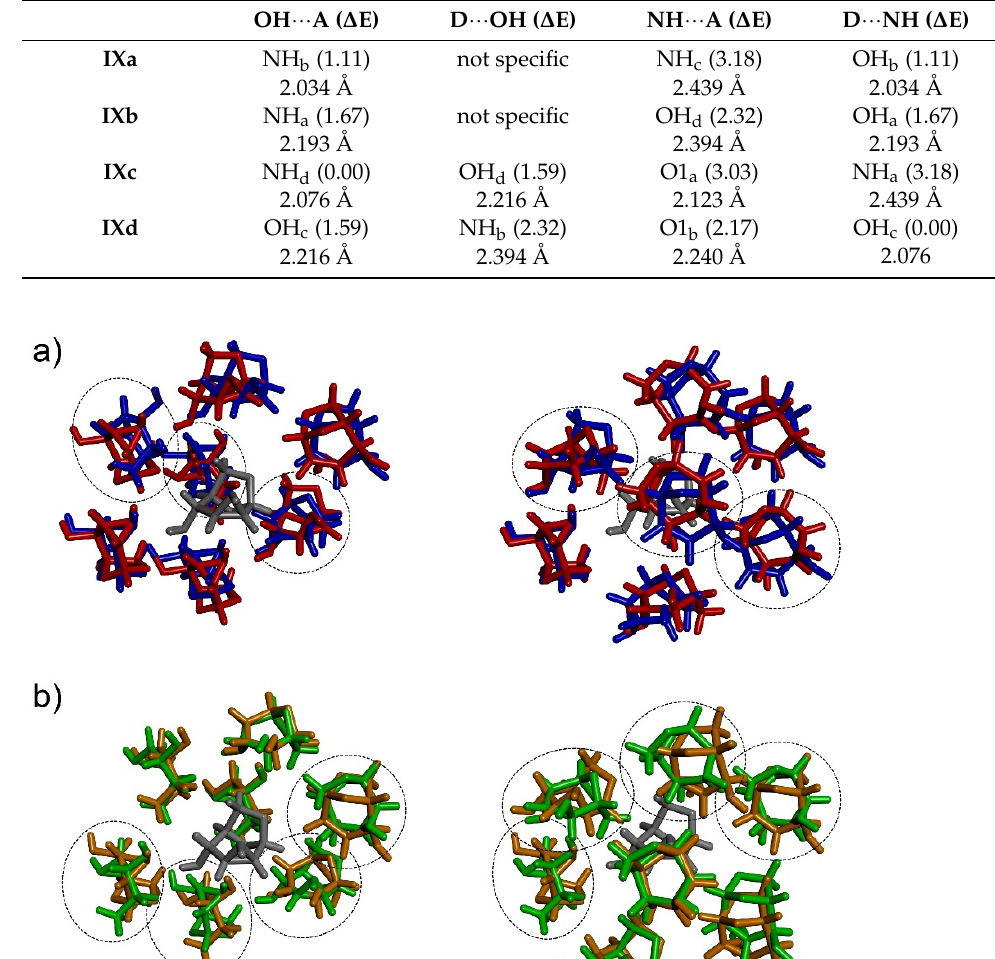
Figure 7. Overlaid independent molecules IX ( a ); electrostatic potential mapped on the surface of IX ( b ), top view (left), bottom view (right). Table 2. Hydrogen bonding in the structure of IX . Δ E in kcal/mol.